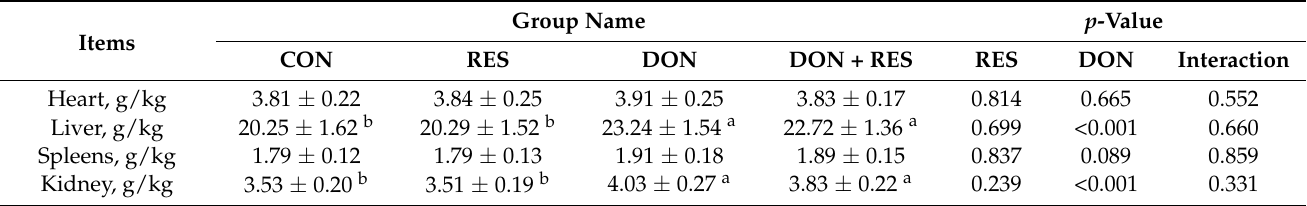
Table 4. The effects of RES on the organ index of